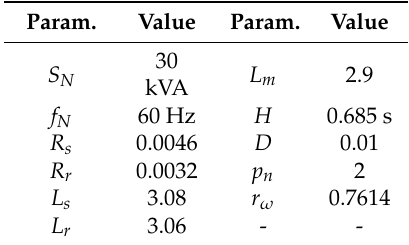
Table 3. DFIG model